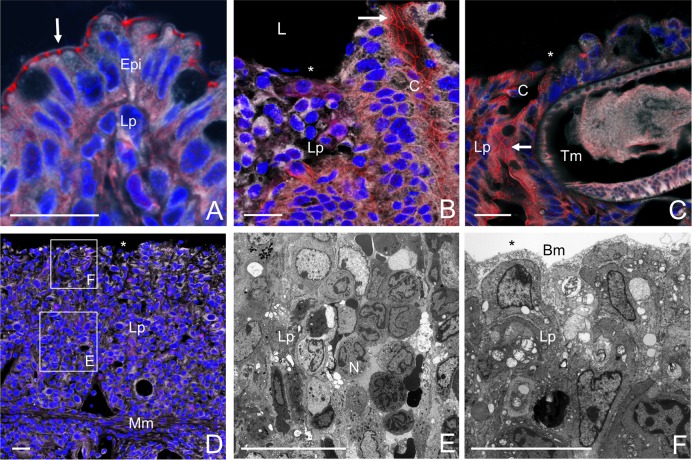
Defective IL-10Rα signalling during T. muris infection results in caecal epithelial barrier breakage.(A) Representative immunofluorescence images of intact tight junctions (ZO-1 positive cells) in epithelium of whipworm-infected WT mice. (B-F) Epithelial barrier breakage in whipworm-infected IL-10Rα mutant mice. Representative immunofluorescence images of denuded epithelium with lack of tight junctions in areas with inflammatory infiltrate (B, D) and cells surrounding whipworms (C). Representative electron micrographs of regions E and F in the inflammatory infiltrate of panel D (D-E). Red, tight junction protein ZO-1; grey, membranes; and blue, cell nuclei. Tight junctions (arrows), denuded epithelium (asterisks), Lp = lamina propria, Mm = lamina muscular mucosa, L = lumen, C = crypt, N = neutrophil, Bm = basement membrane, Epi = epithelium, Tm = T. muris. Scale bar, 20μm. Results are from two independent replicas (n = 3–4 each).